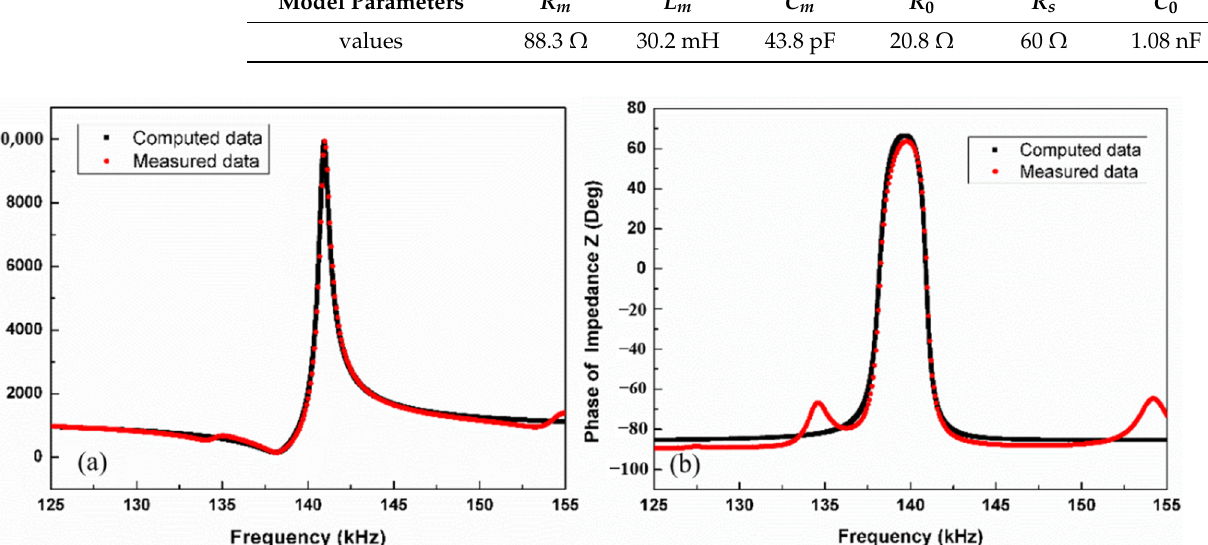
Figure 4. The ( a ) impedance and ( b ) phase angle of the ME sensor as a function of the electrical excitation frequencies ranged from 125 kHz to 155 kHz at H dc = 30 Oe. The maximum RSDs of measured impedances and phase angles are 0.21% and 0.23%, respectively.